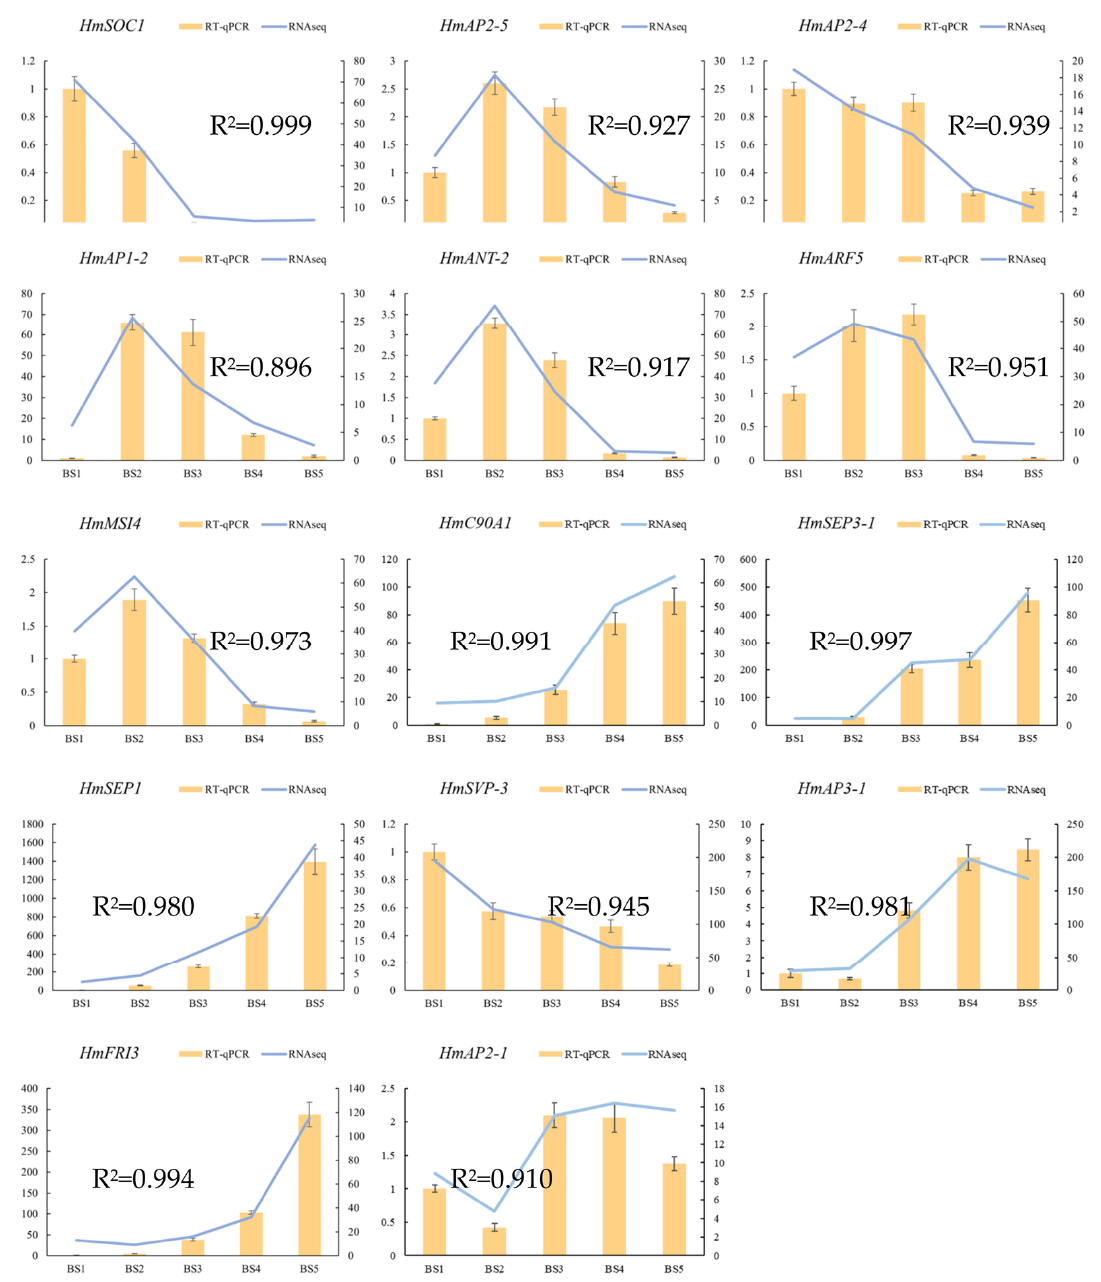
Figure 9. RT-qPCR validation of the expression patterns of 14 DEGs. The x-axis represents the five developmental stages; the left y-axis represents the relative expression levels of RT-qPCR results; the right y-axis represents the FPKM values from RNA-seq. Error bars show the standard error between three biological replicates ( n = 3).